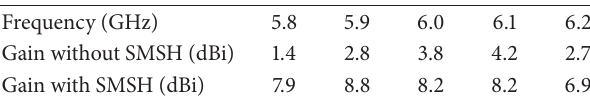
Table 4: Measured gain of a DRA with and without SMSH